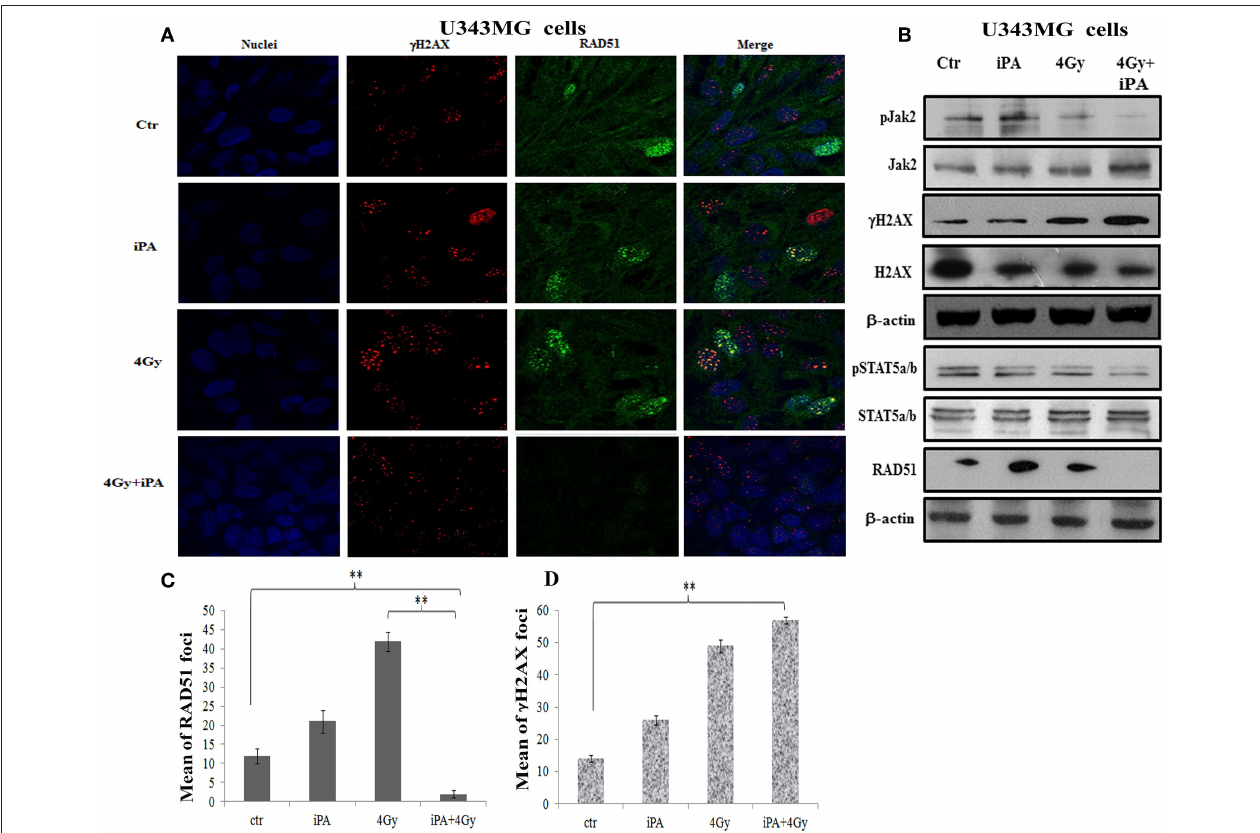
FIGURE 4 | iPA inhibited the RAD51 foci formation of U343MG cells. (A) The cells were plated on glass cover slips and pre-treated with iPA for 48h and then irradiated with 4Gy IR. After 24h wells were washed and analyzed by confocal microscopy for γ H2AX foci (red) and Rad51 foci (green) and Hoechst 33258 for nuclear staining (blue). One representative experiment of a total of three is shown. (B) iPA inhibited the protein levels RAD51 via inactivation of Jak2/Stat5a/b signaling pathway. Whole cell extracts treated with or without 4Gy of IR were collected for Western blot analysis using Jak2, Stat5a/b, RAD51, and γ -H2AX. β -actin was used as an internal loading control. (C,D) DNA damage foci and RAD51 foci were counted and plotted as bar graphs. Approximately 200 nuclei for each treatment group were scored in each experiment, and a threshold of 5 foci per cell was considered positive. Values represent the means of 3 experiments ± SD (ANOVA, * p < 0.05, ** p <